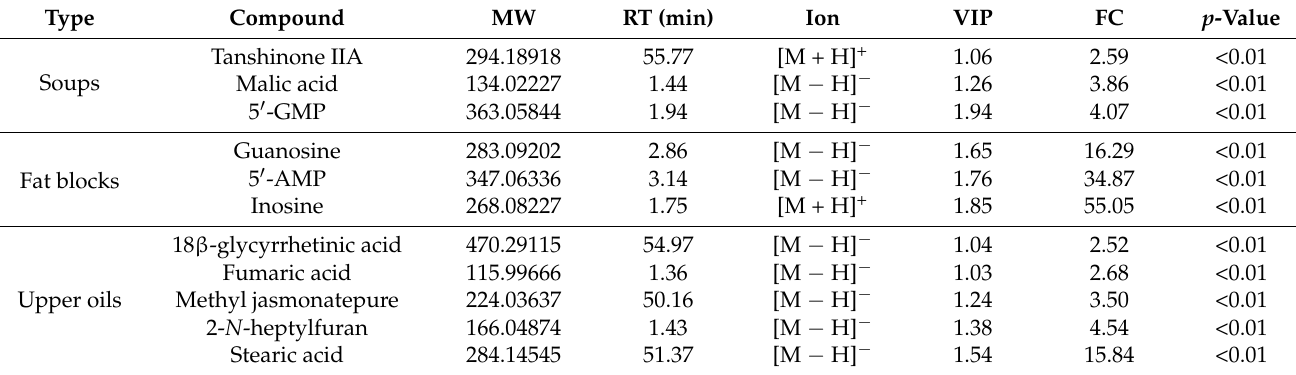
Figure 3. ( A ) PLS-DA score plots of the soup samples (SP-OP and S-OP). ( B ) Cross validation results (The best classifier was indicated by the red asterisk). ( C ) Permutation test results (1000 cycles ( p < 0.05)). Table 1. Information of the marker